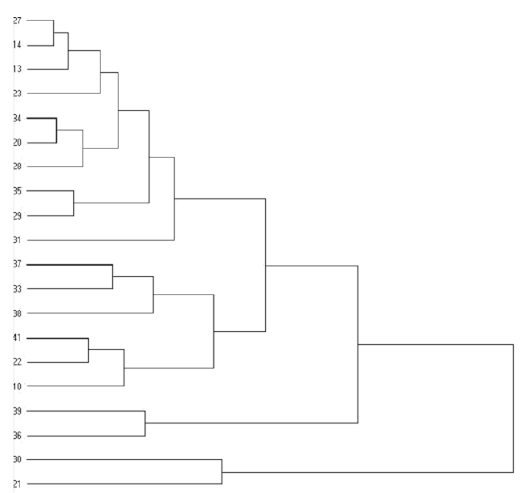
Figure 3. Hierarchical cluster analysis dendrogram obtained on the basis of the anionic composition data (7 variables, 20 samples, fursthest neghbour strategy with chord